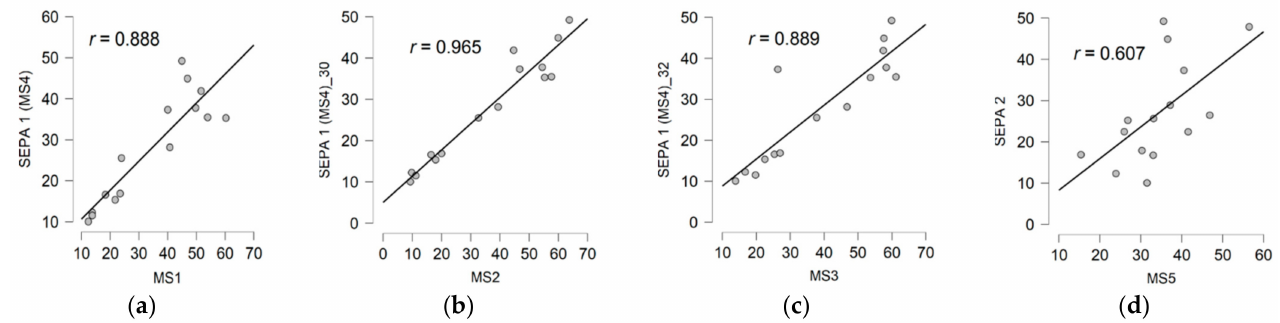
Figure A4. PM2.5 correlation: ( a ) MS1 low-cost sensor vs. SEPA equivalent instrument ( b ) MS2 low-cost sensor vs. SEPA equivalent instrument ( c ) MS3 low-cost sensor vs. SEPA equivalent instrument ( d ) MS5 low-cost sensor vs. SEPA equivalent instrument (at different